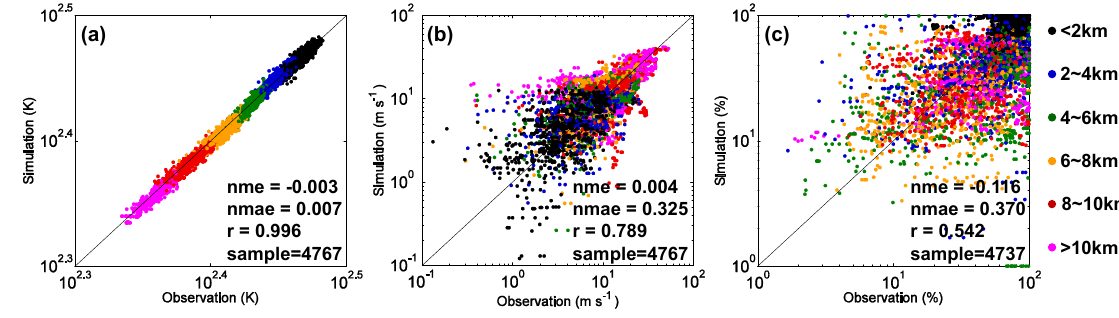
Fig. 1. Scatter diagrams of meteorological parameters simulated by WRF-Chem+APM and the aircraft observations obtained during INTEX-A (6 July to 14 August 2004): (a) temperature; (b) wind speed; (c) relative humidity. The aircraft observations are obtained from minute averaged data of INTEXA DC8. The simulations are obtained according to the date-time and location of each observation along the flight paths. The output of WRF-Chem+APM is an hourly mean.